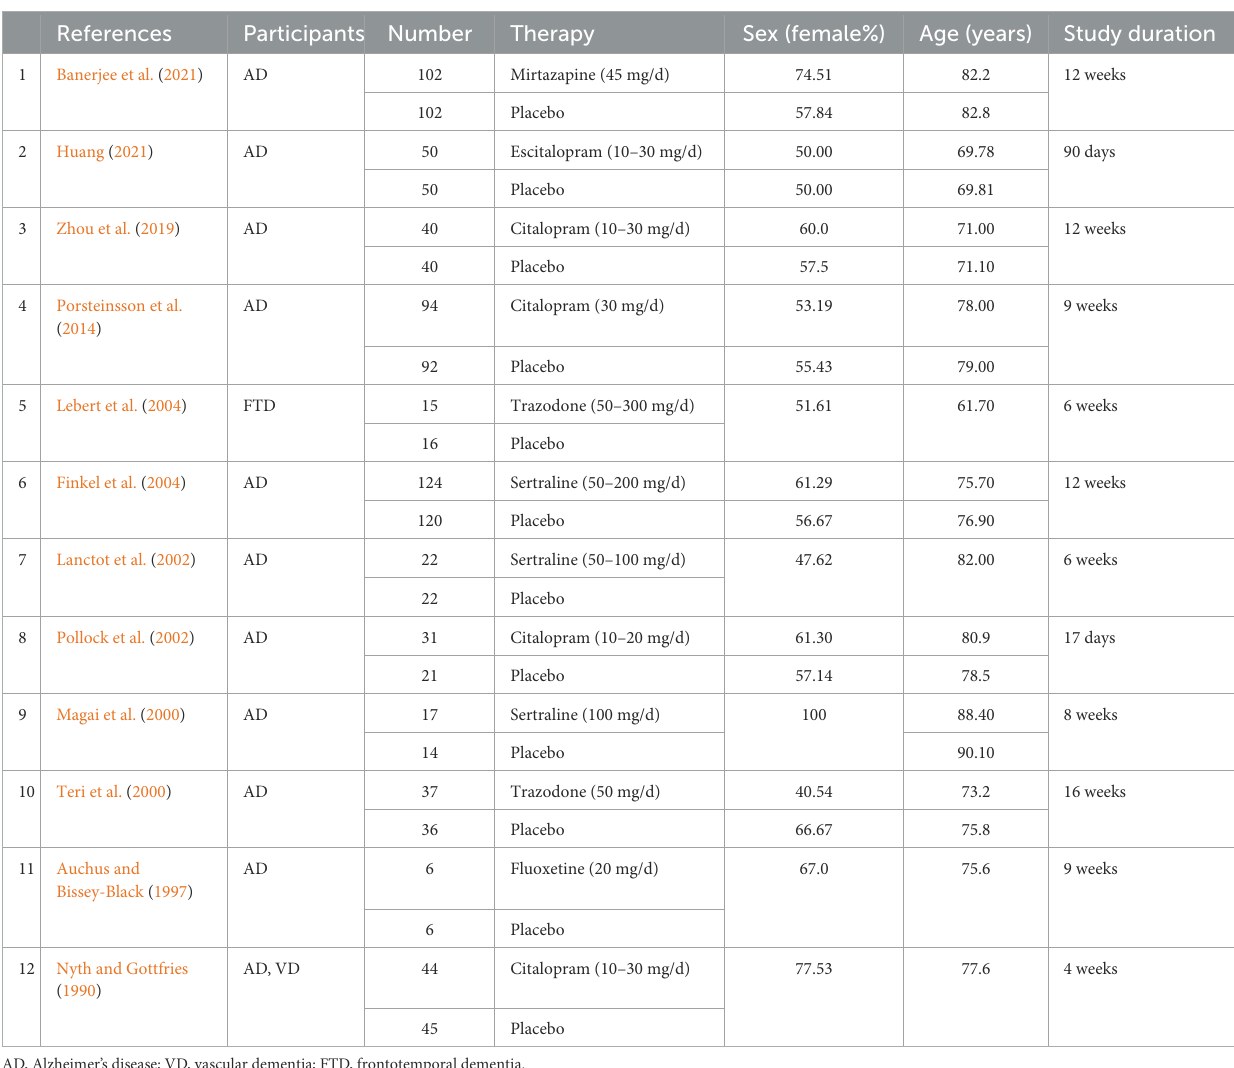
TABLE 1 The characteristics and demographics of the included studies.